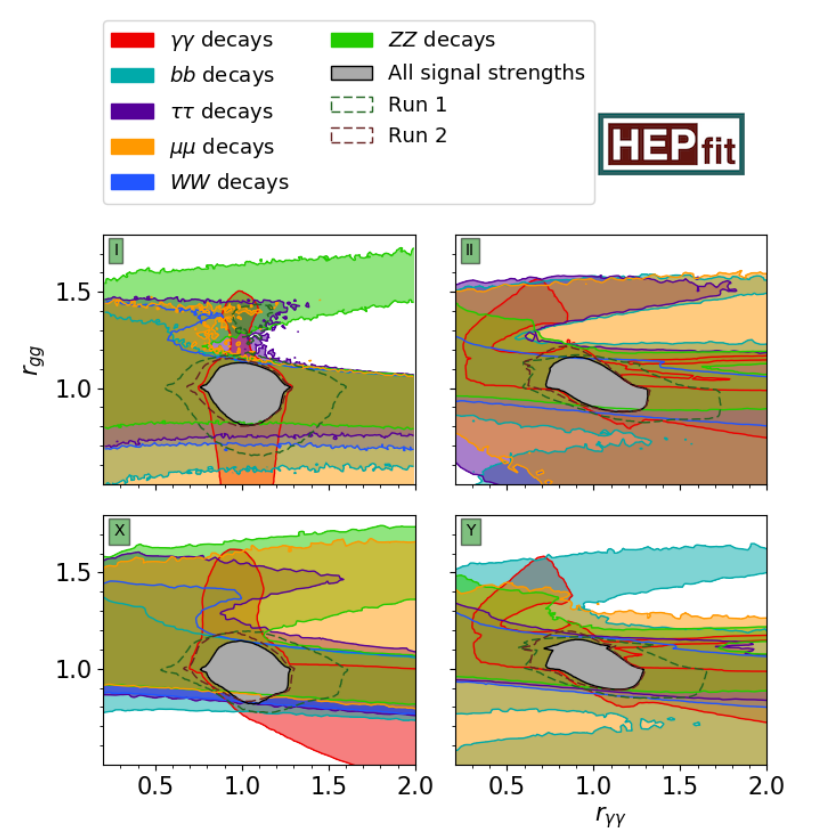
Figure 2 . The 95 : 4% probability contours for di(cid:11)erent combinations of signal strengths are shown in the plane of the relative one-loop couplings of the h to gluons and photons. While the colours of the shaded contours with solid borders correspond to the ones in (cid:12)gure 1, the Run 1 and Run 2 combinations are bounded by the dark green and brown dashed contours,